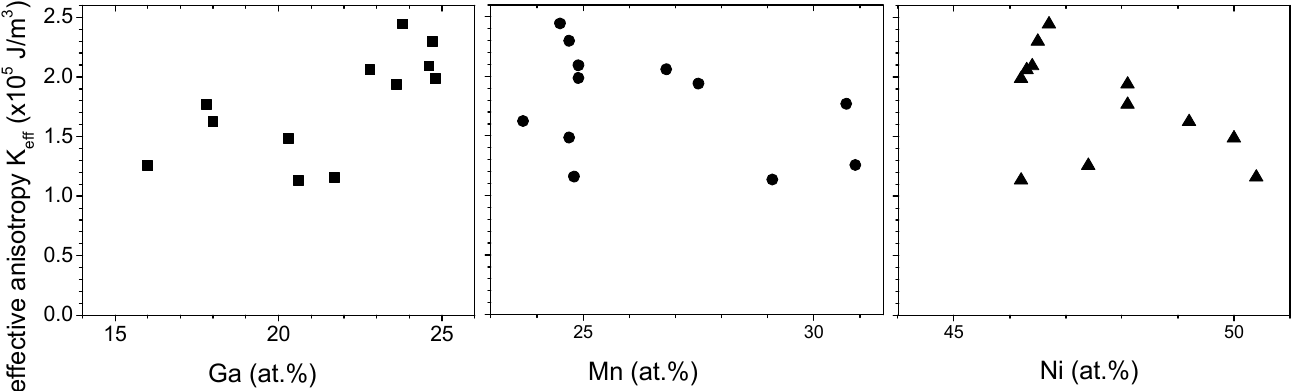
Figure 5. Effective magnetic anisotropy as a function of Ni, Mn and Ga content in Ni-Mn-Ga alloyed with Cu and Fe.